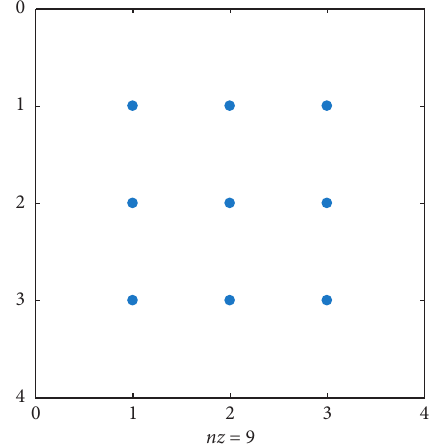
Figure 10: Type 3 thinned virtual array configuration.